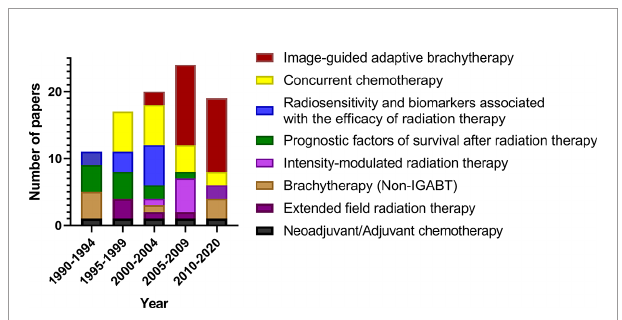
FIGURE 4 | Main research domains in different time periods of the 100 most cited papers in radiotherapy or concurrent chemoradiotherapy for cervical cancer between 1990 and